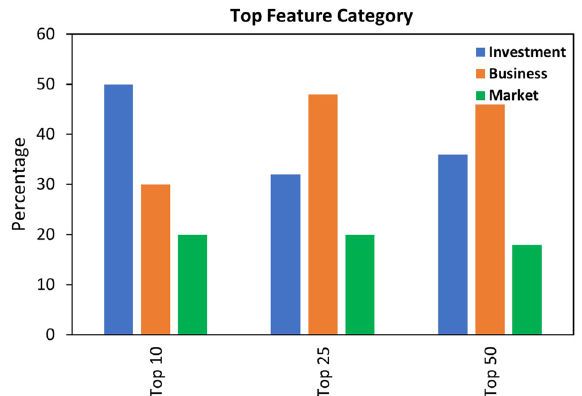
Fig. 14 Percentage of top features in Investment, Business and Market angle